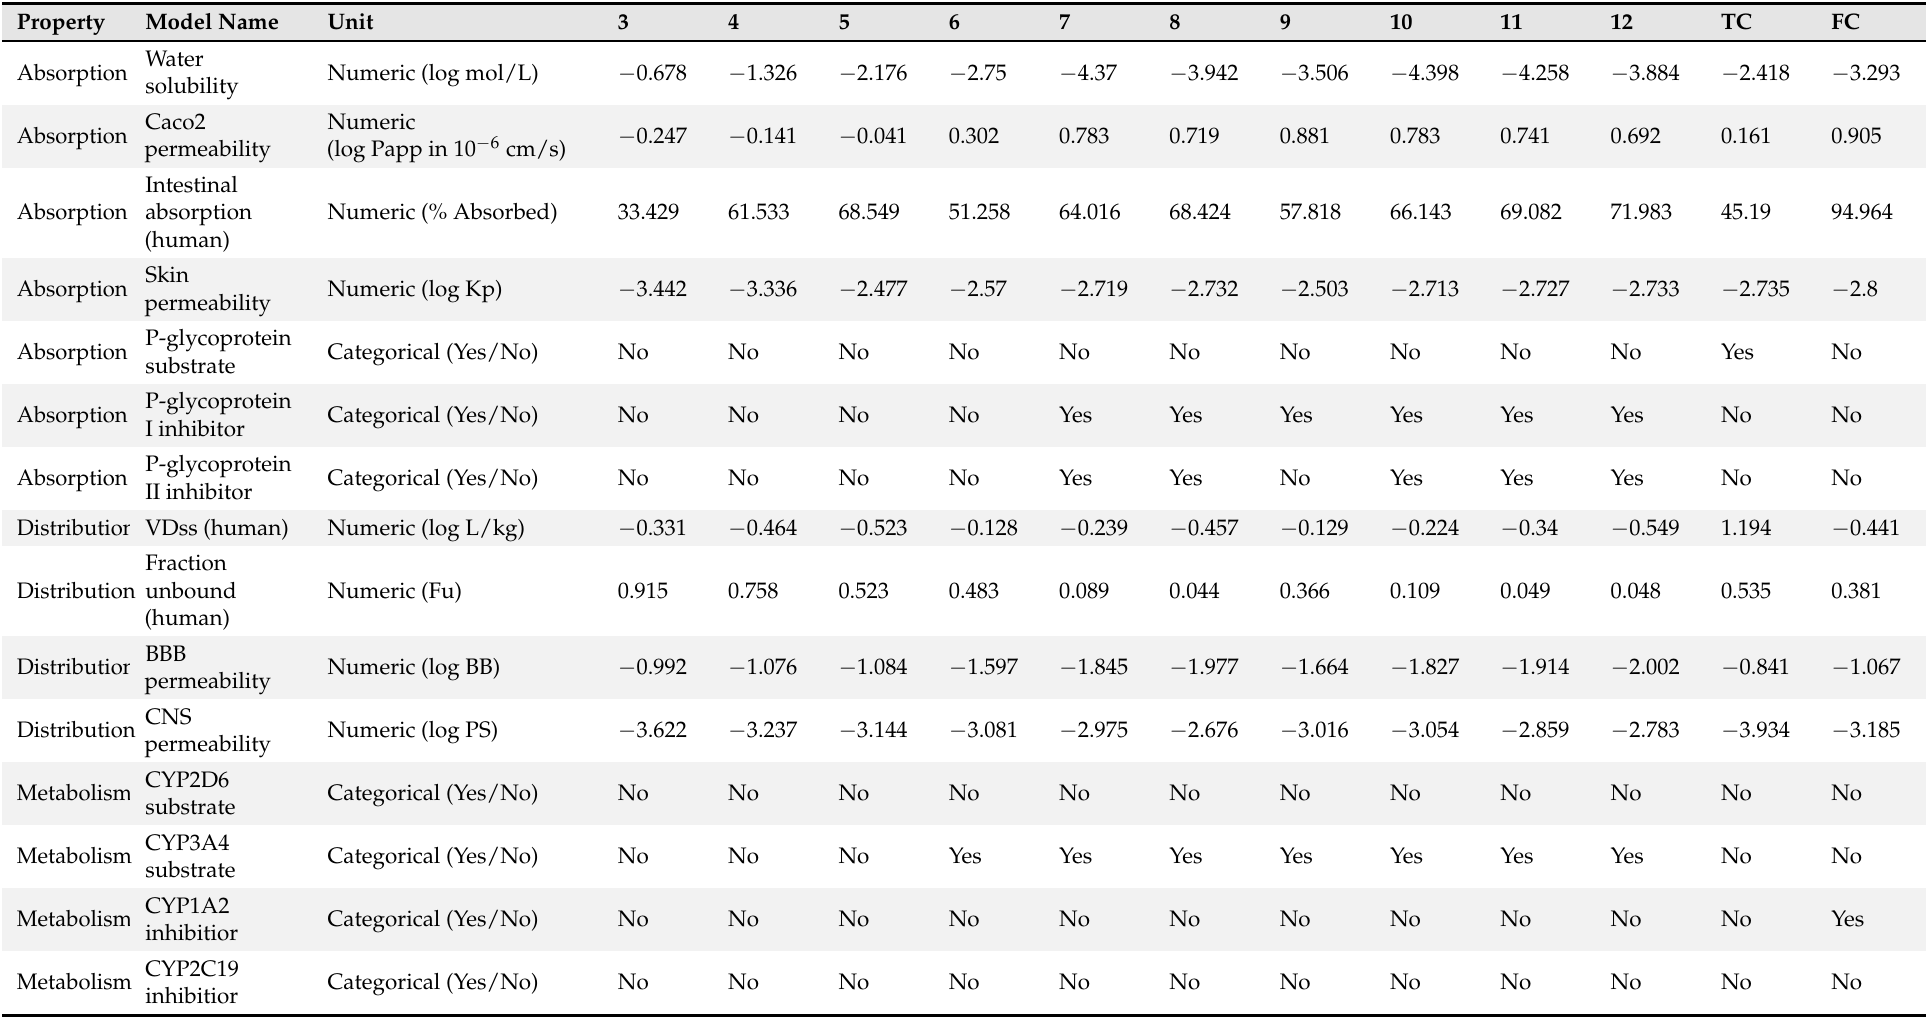
Table 8. ADMET properties of MDG